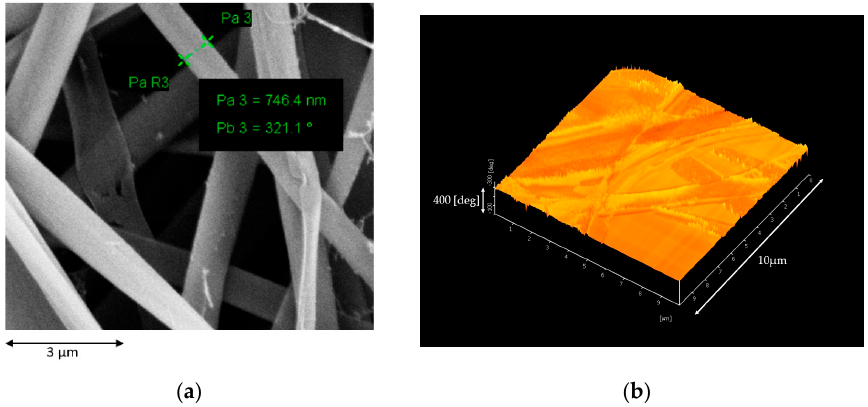
Figure 3. ( a ) Surface morphology of the membrane analysed using FESEM and ( b ) the surface roughness of the membrane by atomic force microscopy (AFM).